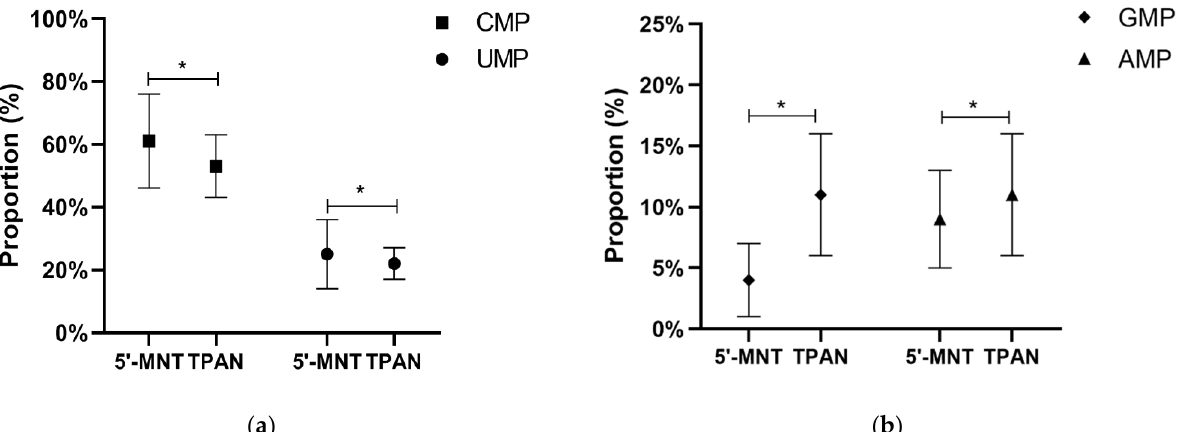
Figure 2. Comparison of 5 ′ -MNT contents and TPAN contents in human milk. ( a ) Comparison of CMP, UMP proportion in 5 ′ -MNT and TPAN; ( b ) Comparison of GMP, AMP proportion in 5 ′ -MNT and TPAN. CMP, Cytidine monophosphate; UMP, uridine monophosphate; GMP, guanosine monophosphate; AMP, adenosine monophosphates; 5'-MNT, free 5'-monophosphate nucleotides; TPAN, total potentially available nucleosides. * Indicates p < 0.05.